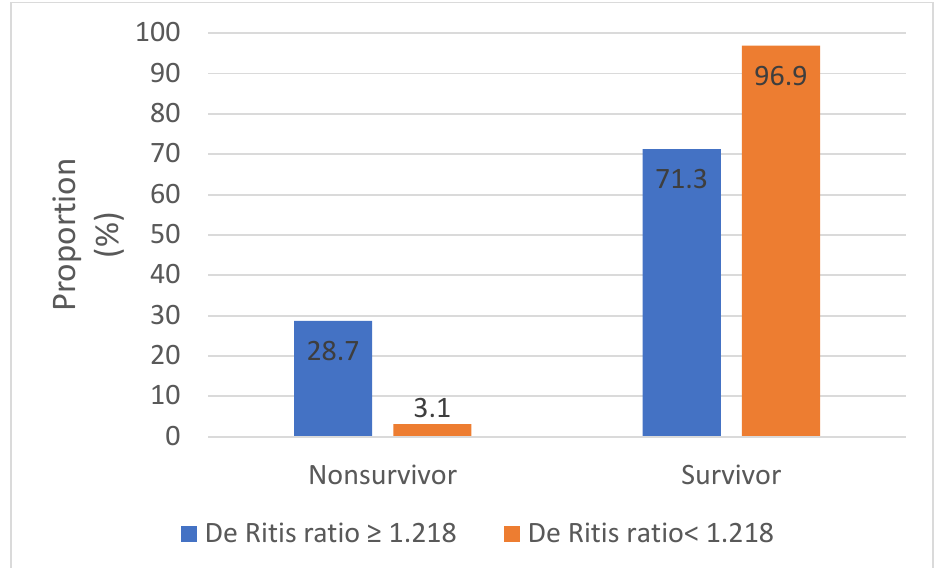
Figure 4. Association between De Ritis ratio and mortality in COVID-19 patients. Table 5. Demographics, clinical and laboratory characteristics of COVID-19 patients grouped by the optimal cut-off value of the De Ritis ratio .